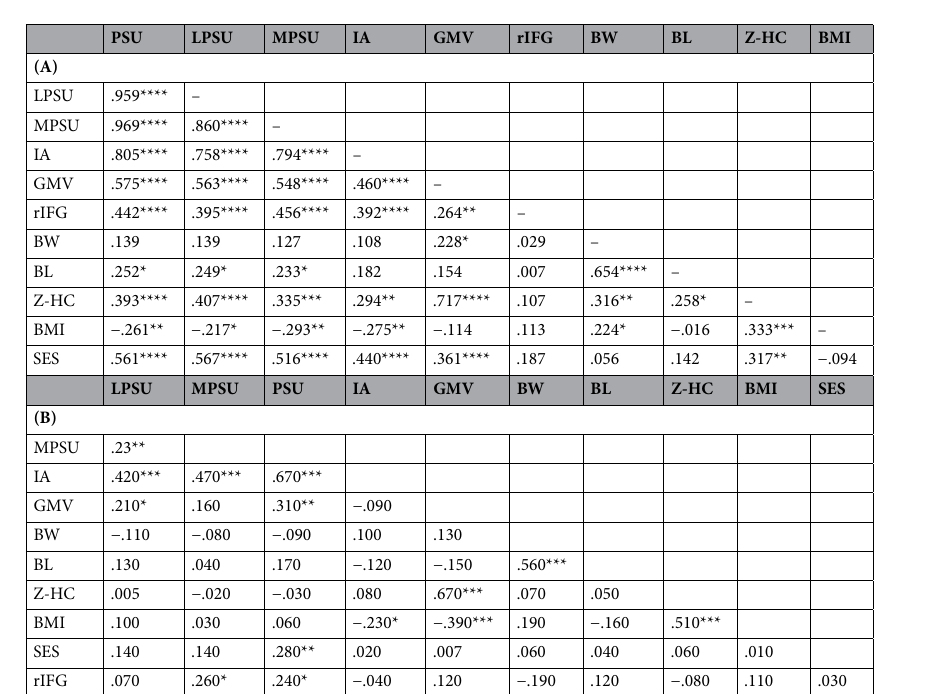
Figure 4. Left: Individual example of subcortical segmentation. Colors represent the different structures used in the correlation analysis (Brainstem and cerebellum, Caudate, Amygdala, Putamen, Hippocampus, Thalamus, and Pallidum). Right: Correlation between the volume of each structure and the University Selection Test (PSU) outcomes for both males and females. Color represents the correlation coefficient.